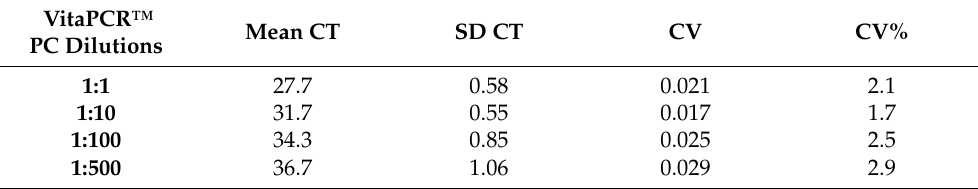
Table 1. Precision of the VitaPCR™.